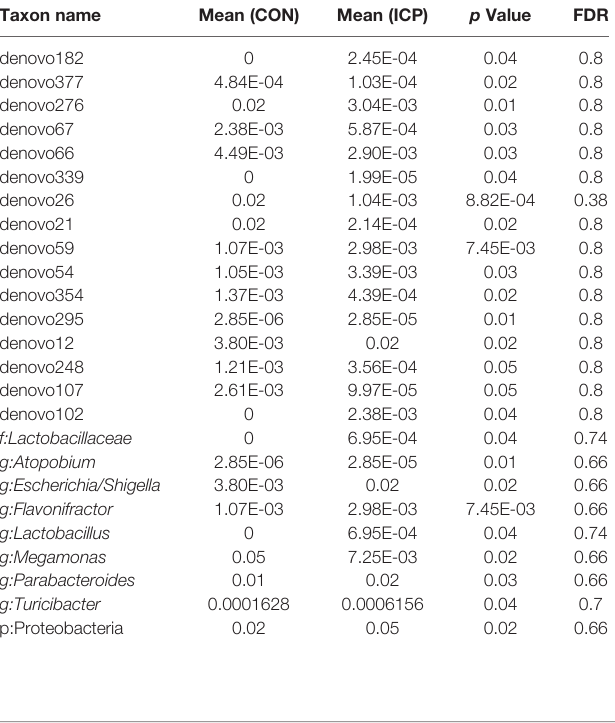
TABLE 2 | The relative abundances of the differential taxa between the ICP and healthy groups.